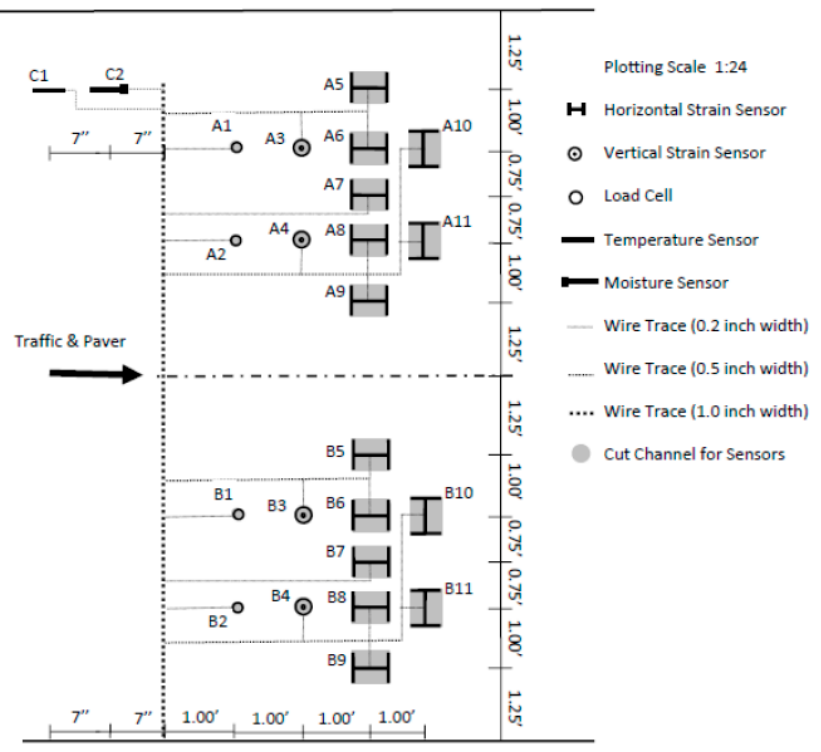
Figure 10. Layout of the sensors in Route 114 (figure is reproduced from Wang et al. [39]).